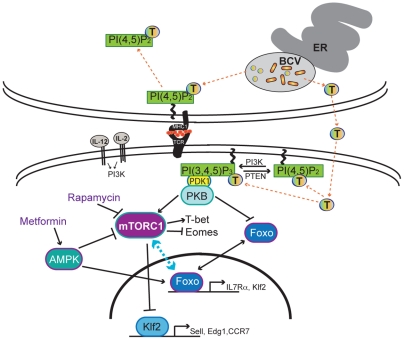
Model of TcpB disruption of adaptive immune response during brucellosis. T =  TcpB; BCV  =  Brucella containing vacuole; ER  =  endoplasmic reticulum. TcpB can inhibit CD8+ T cell specific killing of B. melitensis specific target cells. We hypothesize that this inhibition results from the binding of TcpB to PI(4,5)P2 and either blocking its action or sequestering it away from the APC side of the immunological synapse. Also, TcpB contains a membrane translocation domain that may allow it to travel into the responding CD8+ T cell. We hypothesize that TcpB binding of PI(4,5)P2 and PI(3,4,5)P3, TcpB is disrupting by either up-regulating or down-regulating the action of FoxO and/or mTOR. We hypothesize that this disruption leads to decreased numbers of CD8+ T cell making the effector to memory transition necessary for protective immunity. IL-2 and IL-12 activate PI3K which phosphorylates PI(4,5)P2 into PI(3,4,5)P3. This triggers activation of PKB by PDK1, which can then phosphorylate FoxO and lead to its degradation, and PKB can activate mTOR complex 1. mTORC1 can then up-regulate T-bet, down-regulate Eomes, activate Klf2, and possibly activate FoxO. These actions regulate the fate (short-lived effector or long-lived memory) of the responding CD8+ T cell. Rapamycin and metformin target mTOR and AMPK respectively leading to modulation of memory cell development. Adapted from [17].